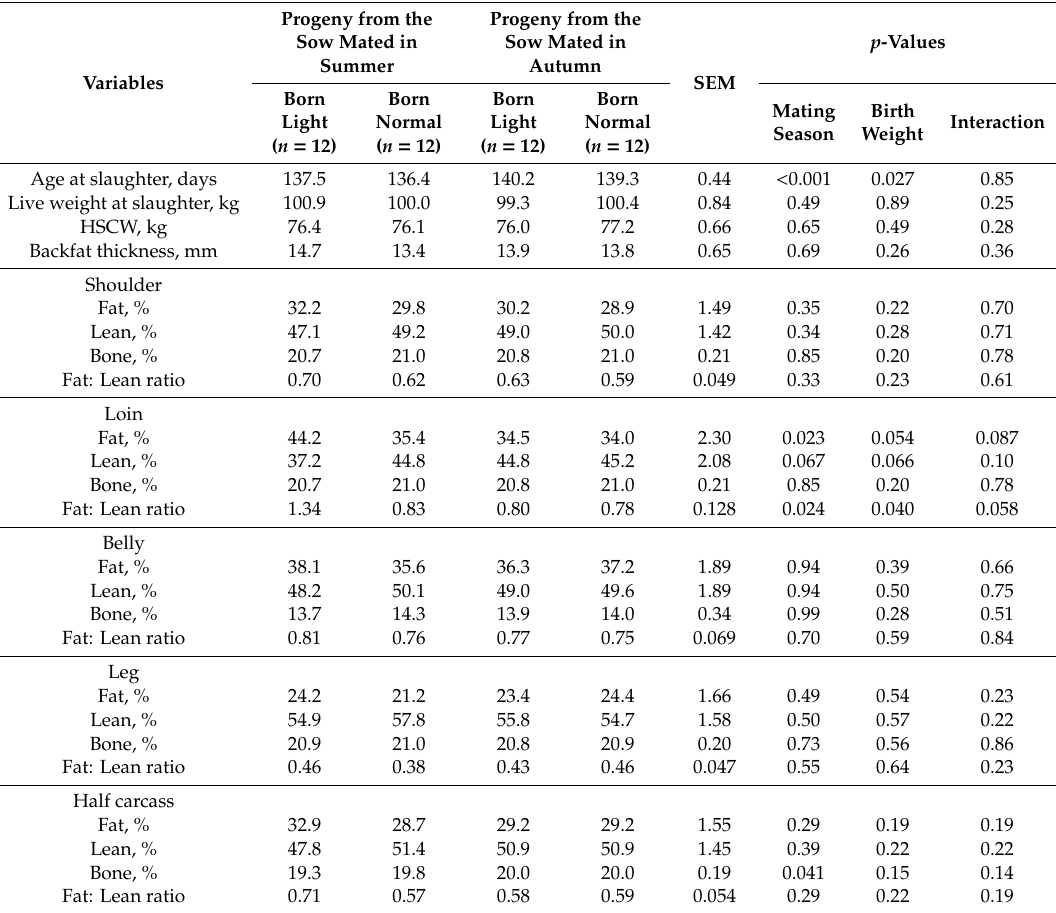
Table 6. Tissue composition (Dual-energy X-ray absorptiometry [DXA] method) of primal cuts and half carcasses of focal progeny pigs born to sows mated in summer vs. autumn. Progeny from the Sow Mated Variables